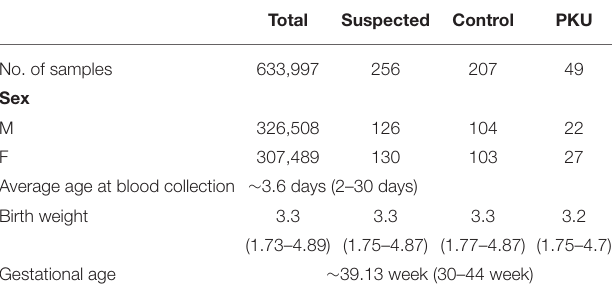
TABLE 2 | The characteristics of newborn